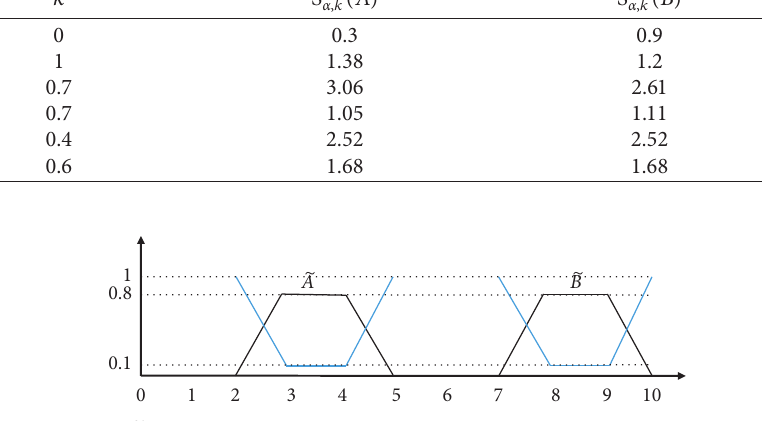
Figure 8: TraIFNs 􏽥 A � 〈( 2 , 3 , 4 , 5 ; 0 . 8 ) , ( 2 , 3 , 4 , 5 ; 0 . 1 )〉 and 􏽥 B � 〈( 7 , 8 , 9 , 10 ; 0 . 8 ) , ( 7 , 8 , 9 , 10 ; 0 . 1 )〉 Table 4: The obtained results from Darehmiraki’s [38] method.